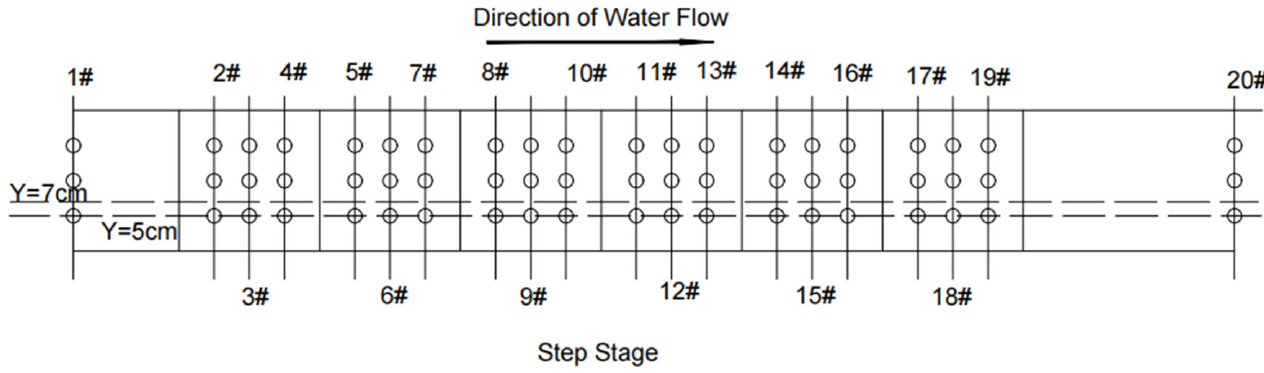
Figure 5. Schematic layout of measurement points.